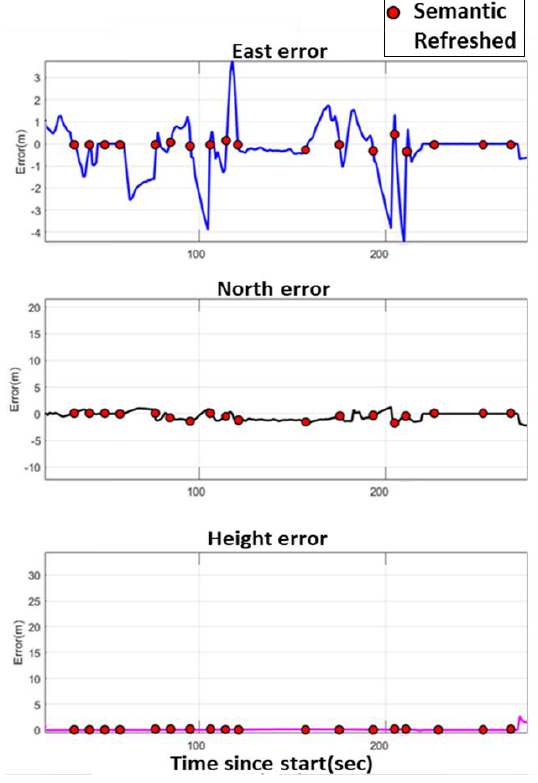
Figure 15. The position error of proposed INS/VINS/ODR integration scheme